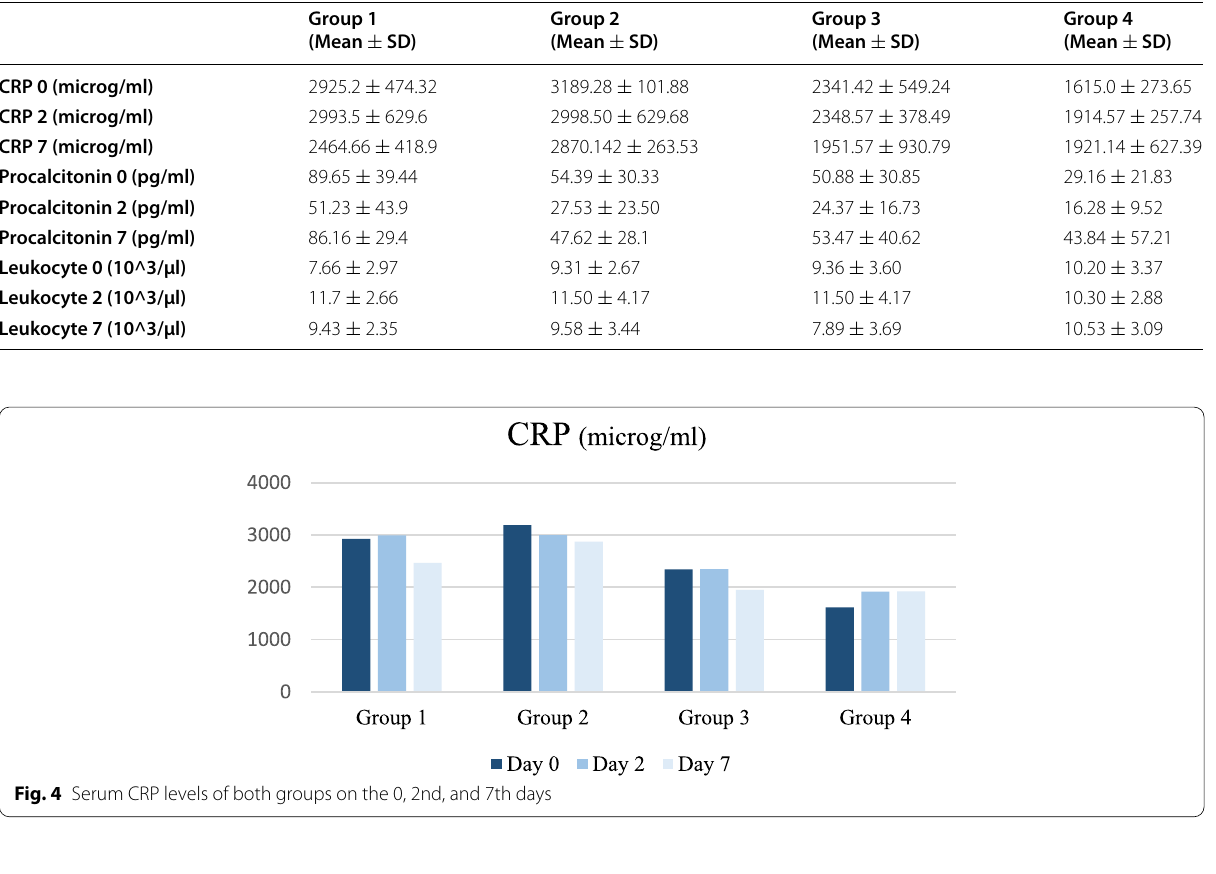
Table 1 Biochemical results of all groups